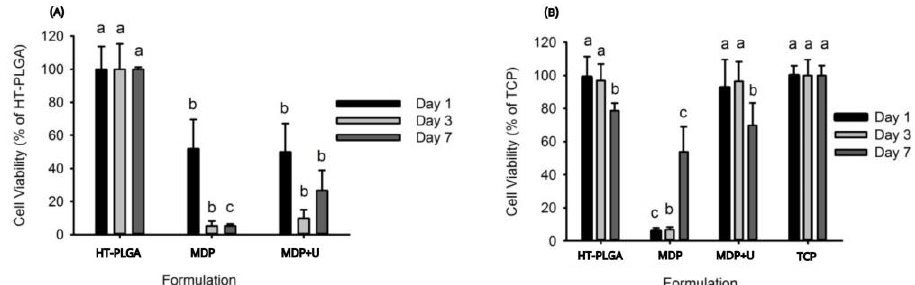
Figure 5. ( A ) Direct cytotoxicity assay, ( B ) Indirect cytotoxicity assay, Tissue culture plastic (TCP). Lowercase letters (a,b,c) denote statistical groupings at each time point.